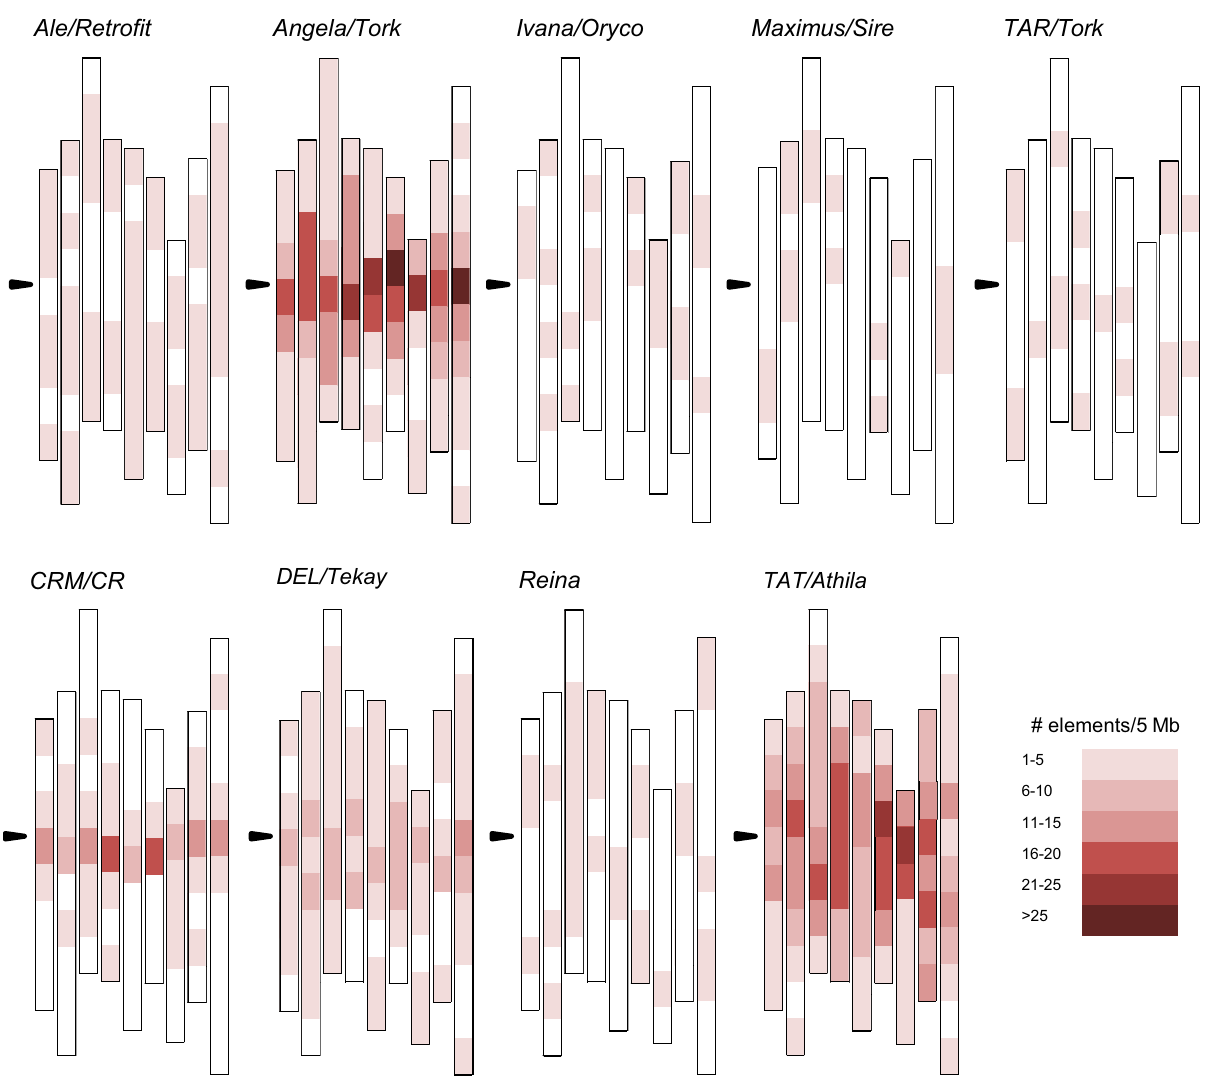
Fig 6. Distribution of LTR-RT lineages in S . italica chromosomes. The nine chromosomes are represented by vertical bars. Black arrows indicate centromeric regions, as previously described [24].